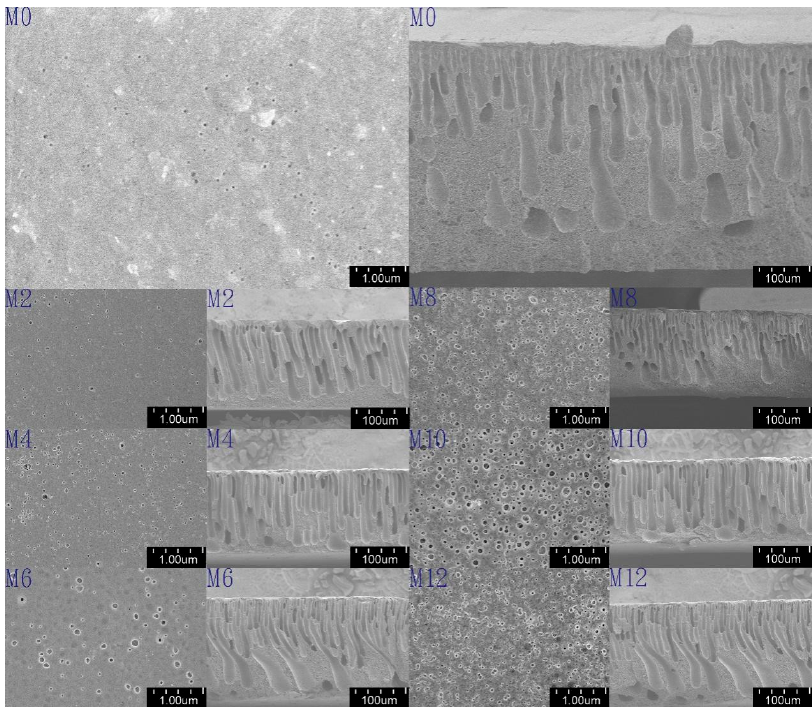
Figure 5. Scanning electron microscope of membranes structure.